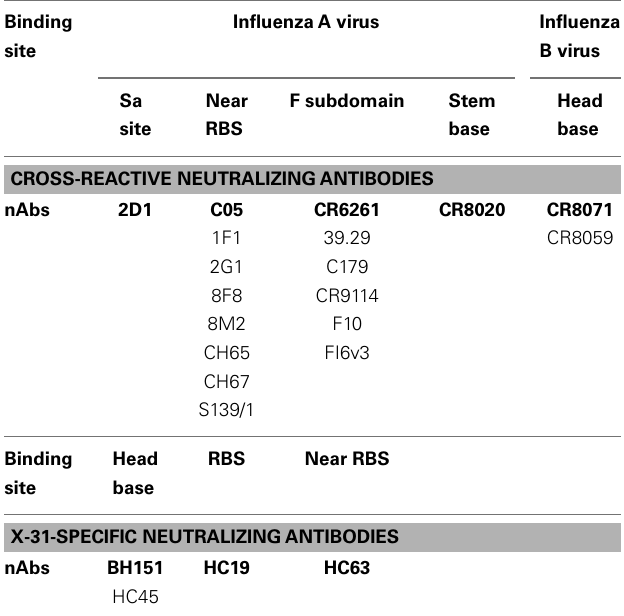
FIGURE 1 | Phylogenetic tree of 17 influenzaA virus subtypes . Representative sequences were selected for each subtype (34) and the phylogenetic tree was made with ClustalX (35) andTreeView (36). H1: A/California/04/2009(H1N1); H2: A/Singapore/1/1957(H2N2); H3: A/Aichi/2/1968(H3N2); H4: A/duck/Czechoslovakia/1956(H4N6); H5: A/VietNam/1203/2004(H5N1); H6: A/chicken/California/431/2000(H6N2); H7: A/Turkey/Italy/8458/2002(H7N3); H8: A/Turkey/Ontario/6118/ 1968(H8N4); H9: A/Swine/Hong Kong/9/98(H9N2); H10: A/chicken/ Germany/N/1949(H10N7); H11: A/duck/England/1/1956(H11N6); H12: A/duck/Alberta/60/1976(H12N5); H13: A/gull/Maryland/704/1977(H13N6); H14: A/Mallard/Astrakhan/263/1982(H14N5); H15: A/shearwater/West Australia/2576/79(H15N9); H16: A/black-headed gull/Sweden/2/99(H16N3); and H17: A/little yellow-shouldered bat/Guatemala/060/2010 (H17N10).